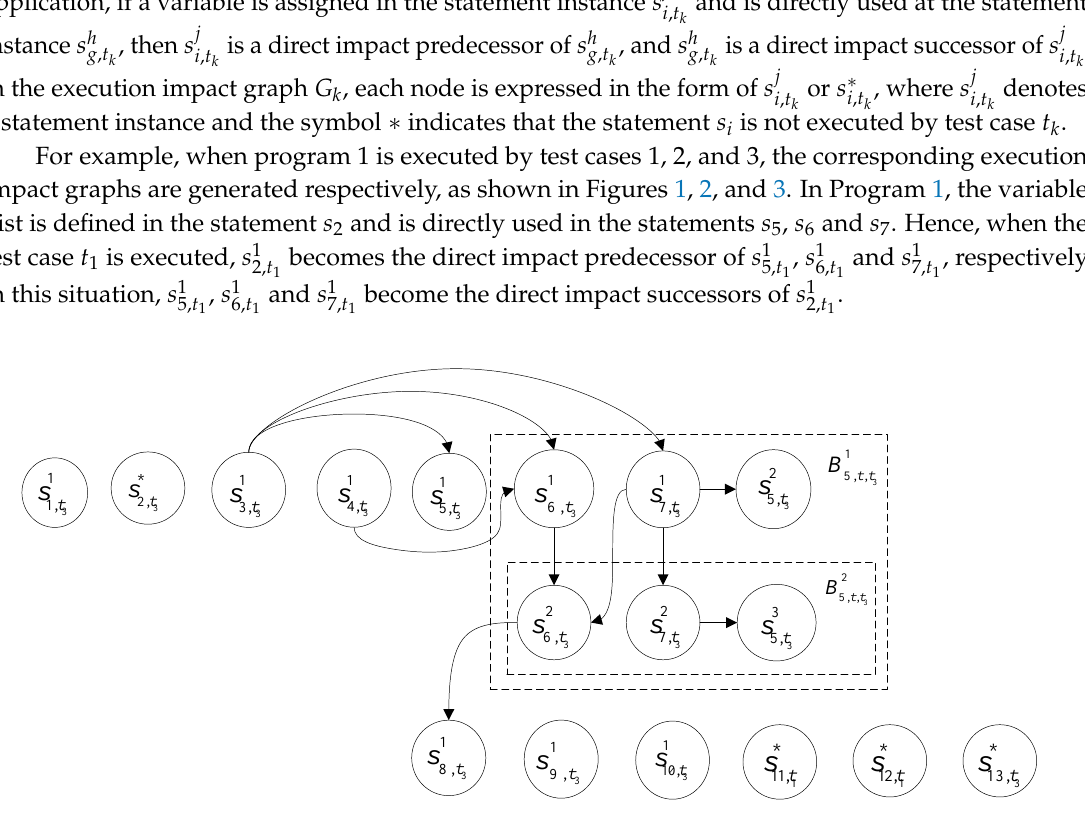
Figure 3. The execution impact graph G 3 formed when Program 1 is executed by test case